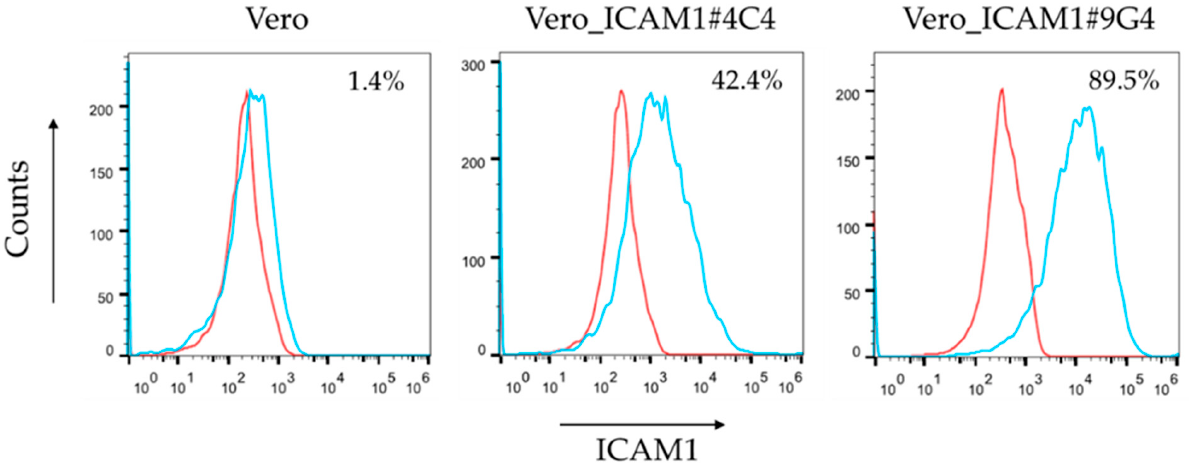
Figure 3. Level of ICAM1 on the surface of two stably transfected Vero clones. Expression of ICAM1 on the cell surface of two selected clones (Vero_ICAM1#4C4 and Vero_ICAM1#9G4), as determined by flow cytometric analyses. In red, staining with a PE-labelled isotype antibody and, in blue, staining with ICAM1-specific antibody. Both clones show ICAM1 expression, with highest expression in Vero_ICAM1#9G4. Percentages indicate proportion of cells expressing ICAM1.